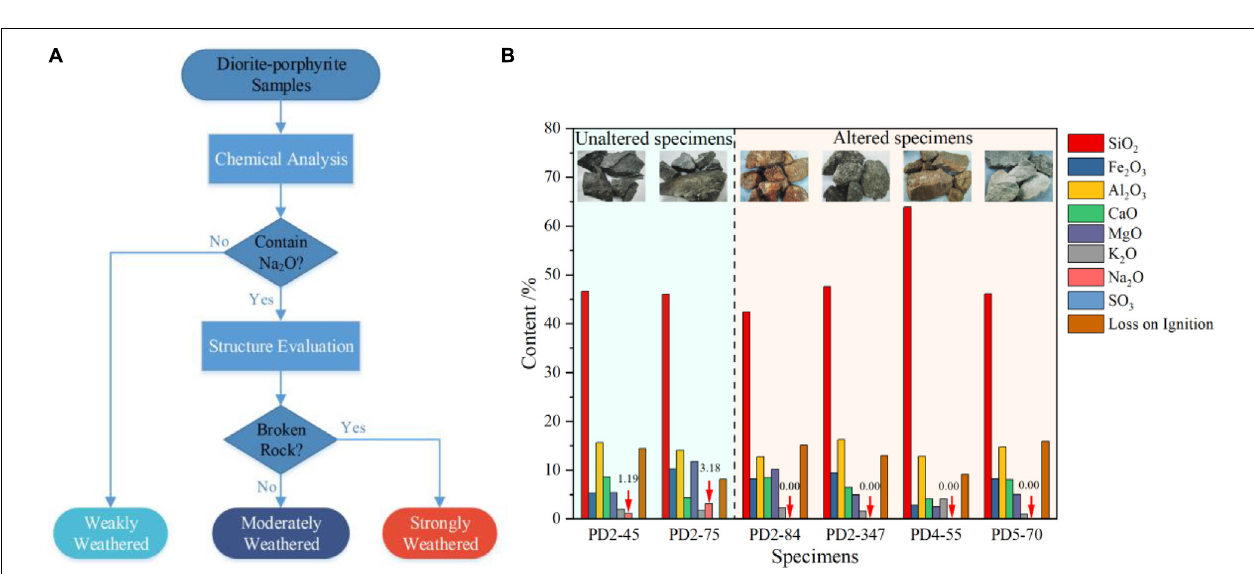
FIGURE 3 | Evaluation of the degree of weathering. (A) Process for determining the degree of weathering. (B) Chemical composition of the content of